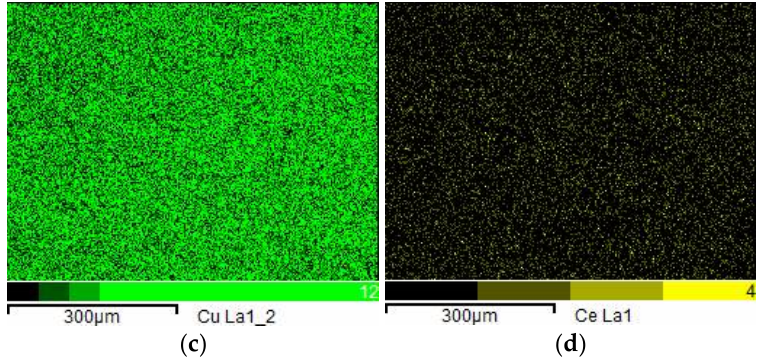
Figure 6. Elemental mapping diagram of the tin plating. ( a ) electron image, ( b ) distribution of tin, ( c ) distribution of copper, and ( d ) distribution of cerium.